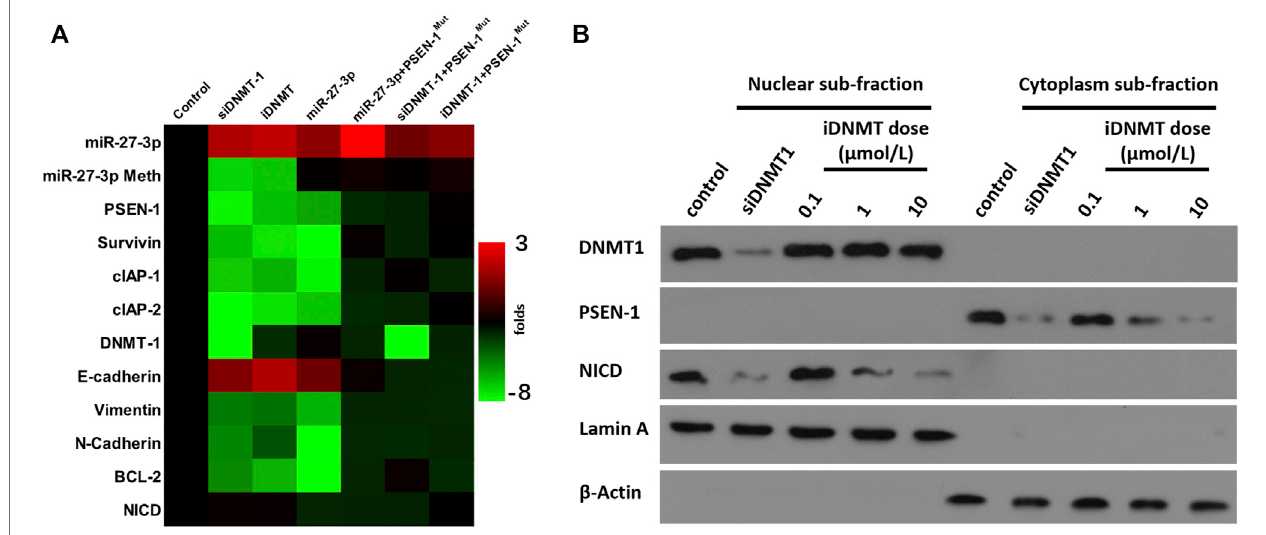
Frontiers in Pharmacology |